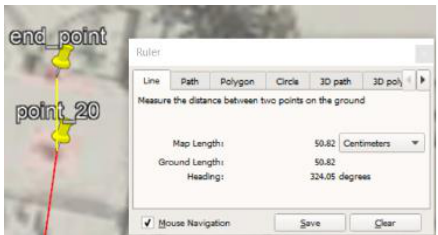
Figure 33. Length and heading to the end point.